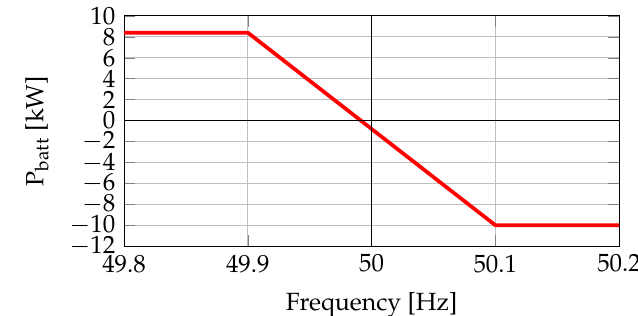
Figure 4. Droop characteristic.